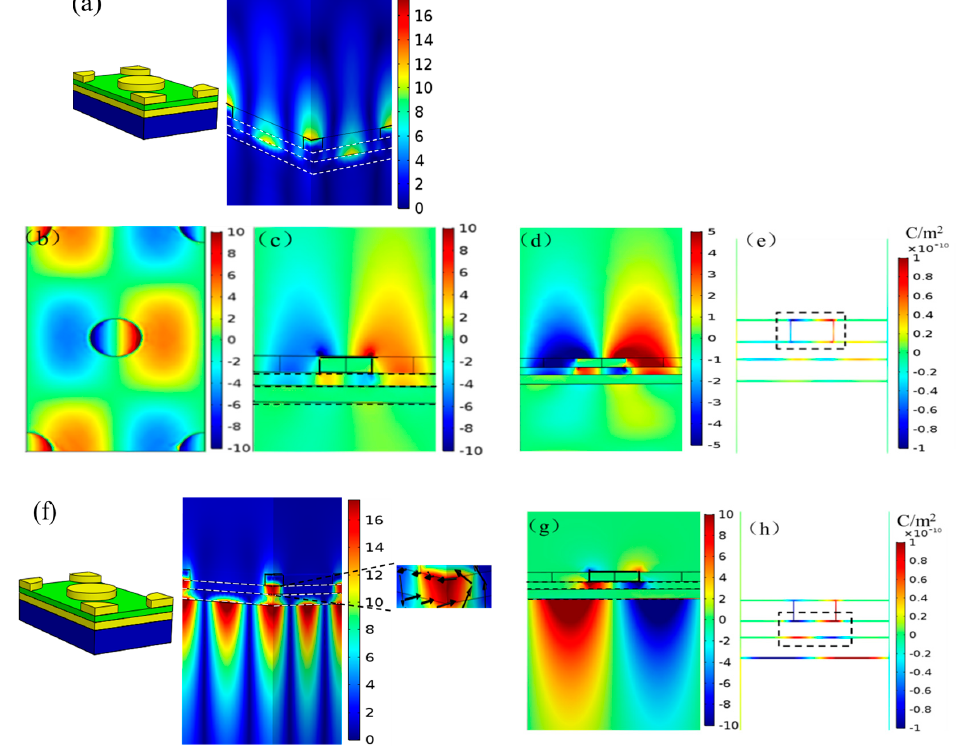
Figure 3. Electromagnetic field and charge distributions for both plasmon resonances with normal incidence. ( a ) Normalized magnetic field distribution at 660 nm; ( b ) normalized electric field distribution for the z component (the most dominant component) at the top surface of the nanodisks at 660 nm; ( c ) the electric field distribution for the z component in the cross section through the center of the hexagonal nanodisk array for a unit cell at 660 nm; ( d ) the z component of the electric field distributions taken as a z -axis slice through the center of the hexagonal nanodisk arrays with a shrinking-scale bar at 660 nm; ( e ) the corresponding charge distribution at 660 nm; ( f ) normalized magnetic field distribution and its partially enlarged distribution at 946 nm. The black arrows represent the direction and intensity of the electric displacement; ( g ) the z component of the electric field distribution taken as a z -axis slice through the center of hexagonal nanodisk array at 946 nm; ( h ) the correspond charge distribution at 946 nm.